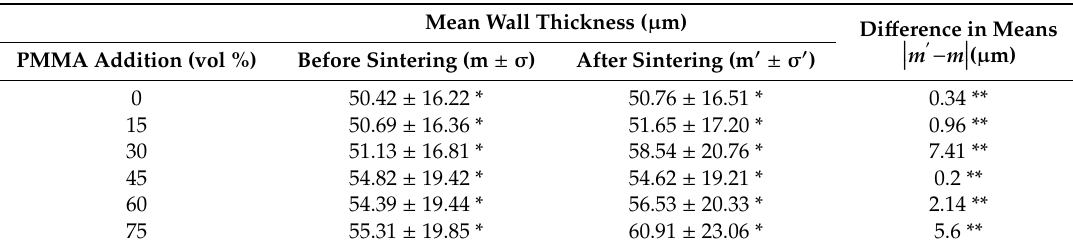
Table 4. Mean wall thickness of the sca ff olds with respect to the PMMA addition amount, before sintering and after sintering.